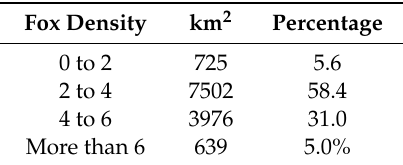
Table 3. Classification of Montenegro in areas with different fox densities. Each area is indicated with its extension in km 2 and its percentage in relation to the entire Montenegro area.